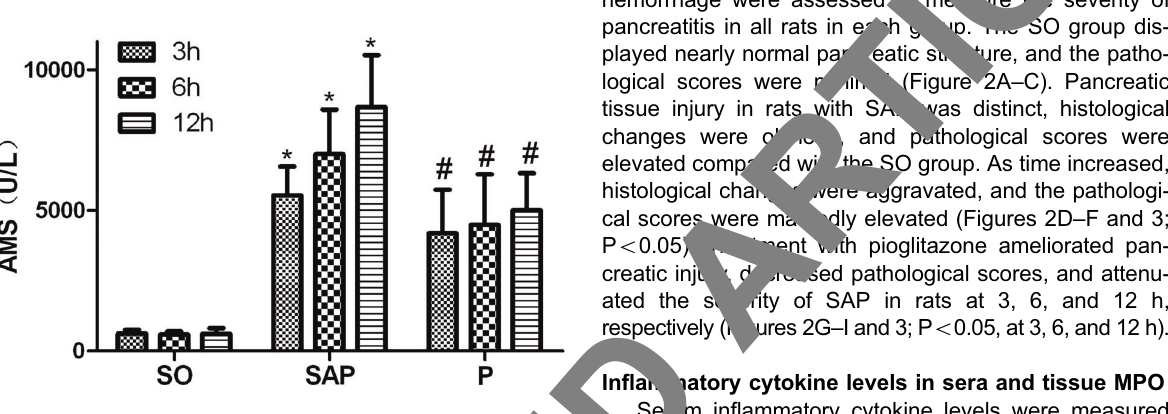
Figure 1. Serum amylase (AMS) in each group at 3, 6, and 12 h. Data are reported as means ± SD. *P o 0.05 compared with the sham operation (SO) group; # P o 0.05 compared with the severe acute pancreatitis (SAP) group (ANOVA). P: pioglitazone group.